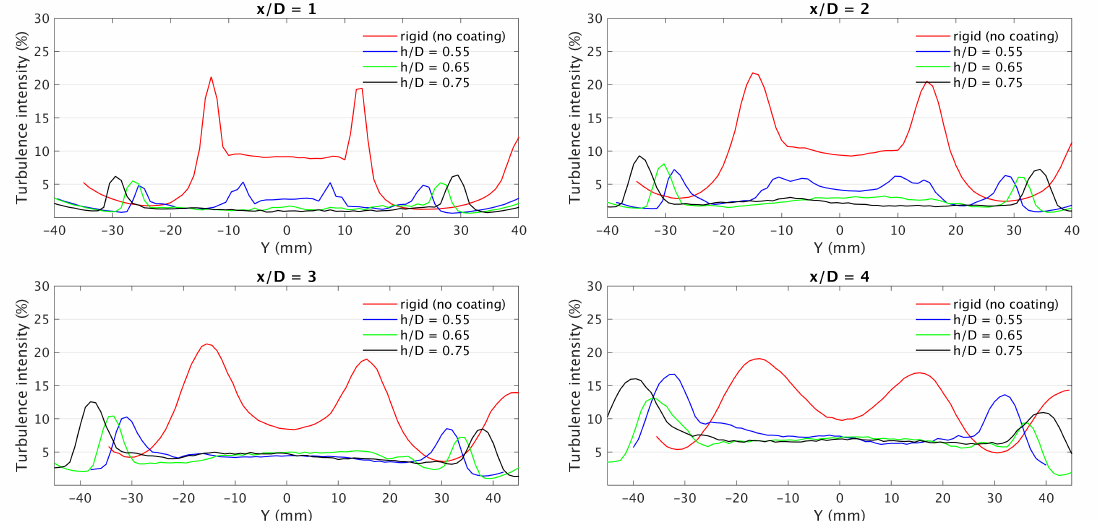
Figure 15. Turbulence intensity graph for cylinder 1 and